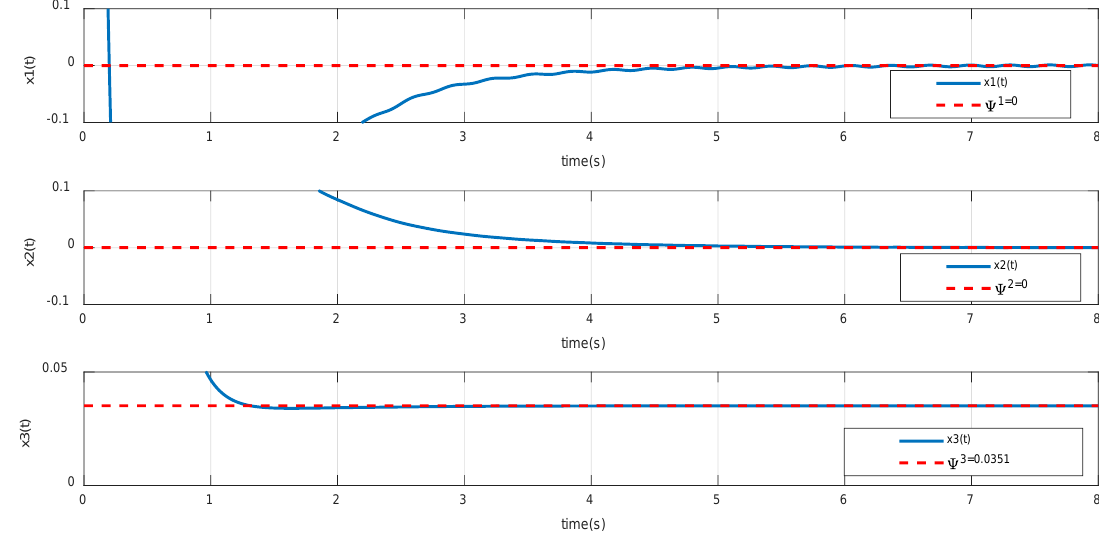
Figure 4. Zoom the dynamics of x 1 ( t ) , x 2 ( t ) , x 3 ( t ) from Figure 3.